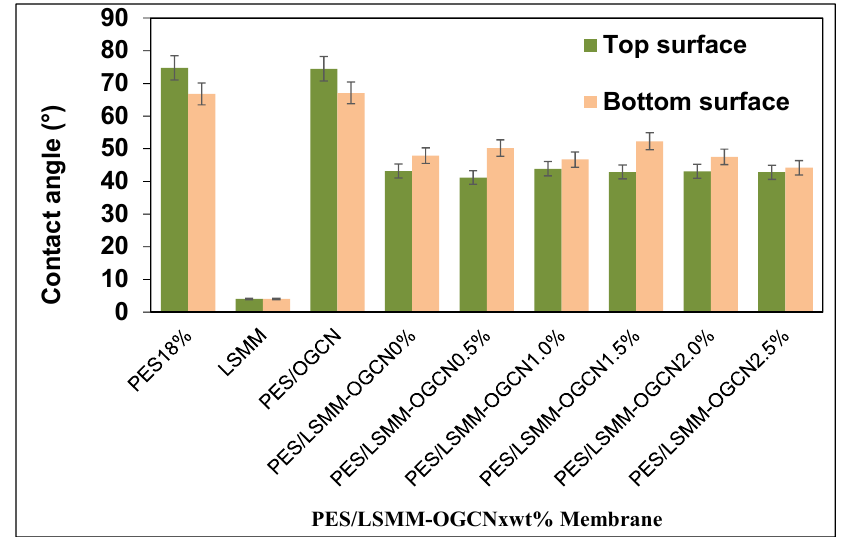
Figure 7. PES/LSMM ‐ OGCN membrane contact angle. Figure 7. PES/LSMM-OGCN membrane contact